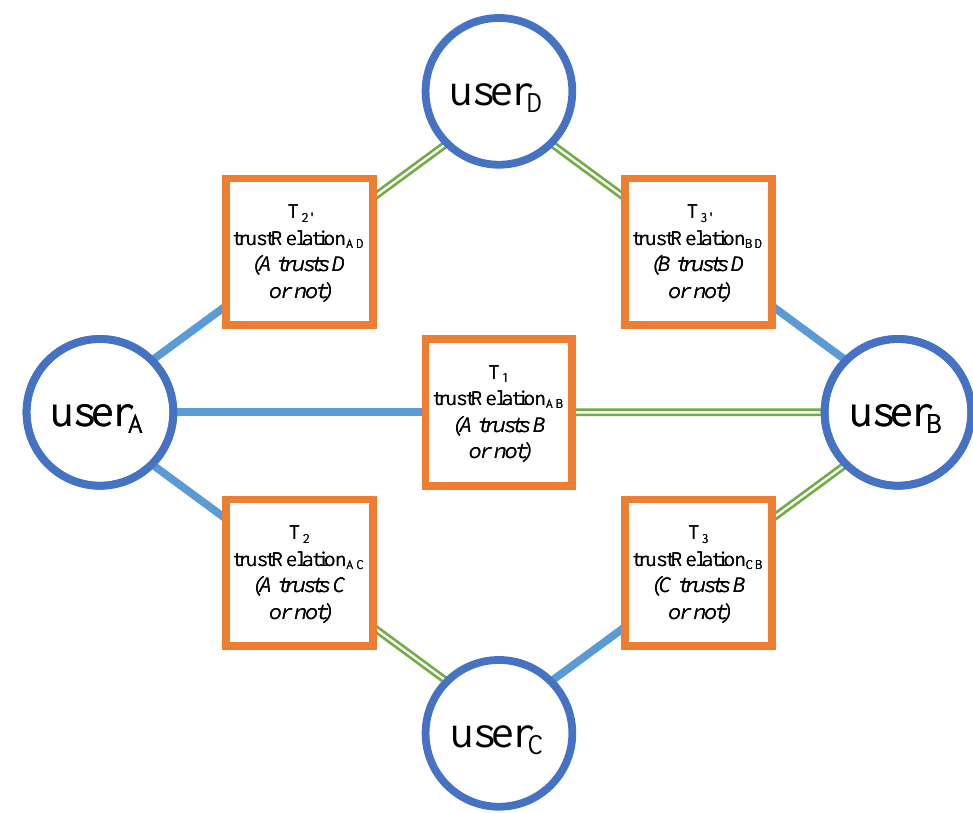
Figure 4. Illustration of direct trust and transposed trust for a trustRelation node in a 3-trustRelation- nodes motif. (T 2 and T 3 contribute direct trust to T 1 ; and T 2 (cid:48) and T 3 (cid:48) contribute transposed trust to T 1